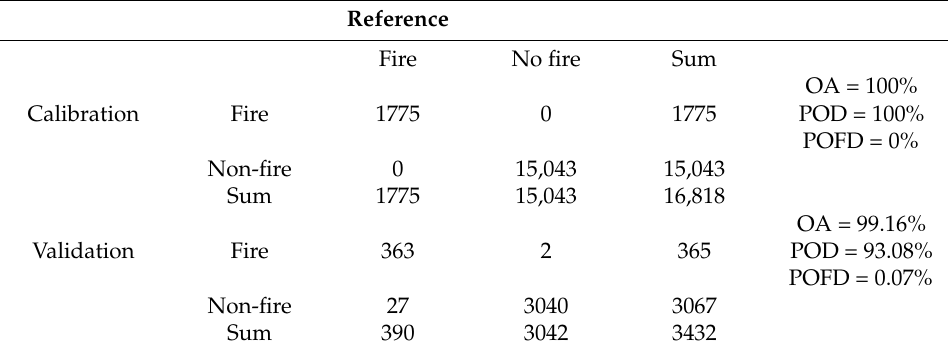
Table 3. Accuracy assessment results of best combinations of RF based on variable importance. (OA = Overall accuracy (%); POD = Probability of detection